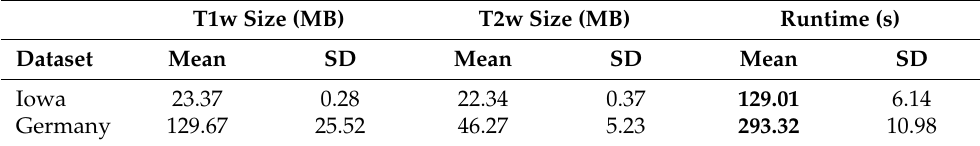
Table 7. Pipeline’s runtime analysis. Running PigSNIPE using CPU inside a Docker container took around two minutes for Iowa and 5 min for German datasets to perform full analysis. Image files in the German dataset were much larger than those in the Iowa dataset, leading to an increased